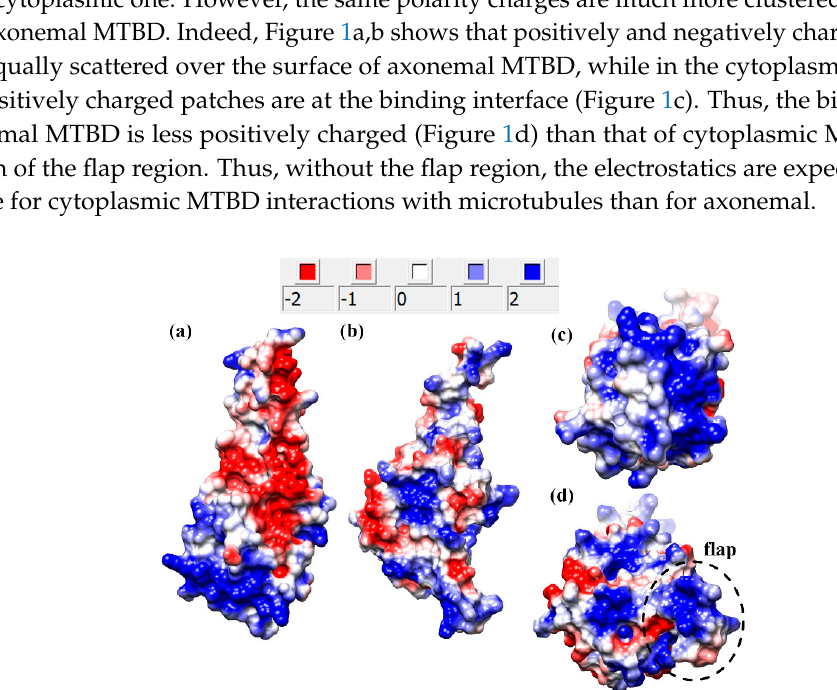
Figure 1. Electrostatic potential mapped onto the surface of microtubule-binding domains (MTBDs). Panels ( a ) and ( b ) show a side view of the electrostatic potential mapped onto the molecular surface of cytoplasmic and axonemal MTBDs, respectively. Panels ( c ) and ( d ) present the electrostatic potential on the binding interface for cytoplasmic and axonemal MTBDs, respectively. The flap region is indicated with a dashed circle. (The potential isocontour values, in term of kT/e (electrostatic potential unit), are shown in the legend).